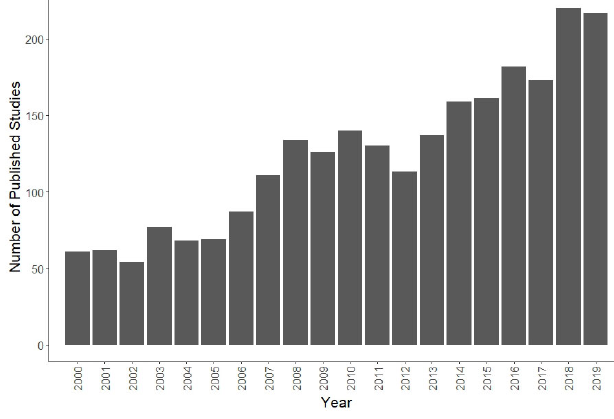
Fig. 1 . The number of disaster-related ecological studies has increased by > 350% over the past 20